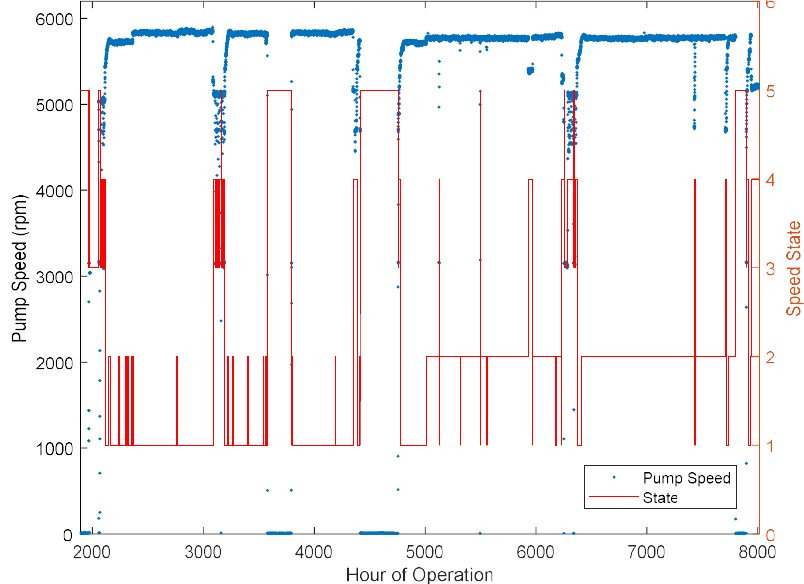
Figure 5. Operating speed regimes for an MBFP over the course of a year against HMM state. States 1 and 2, from the right y-axis, are of interest for normal operation.